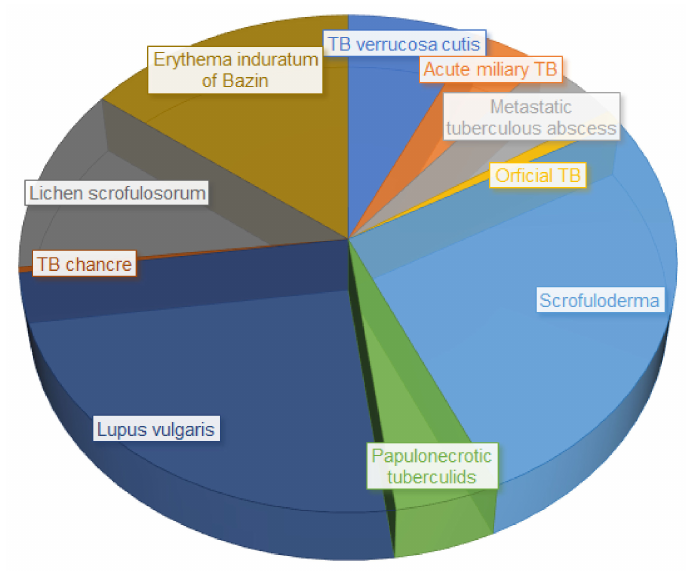
Figure 2. Incidence of different CTB manifestations (adapted from